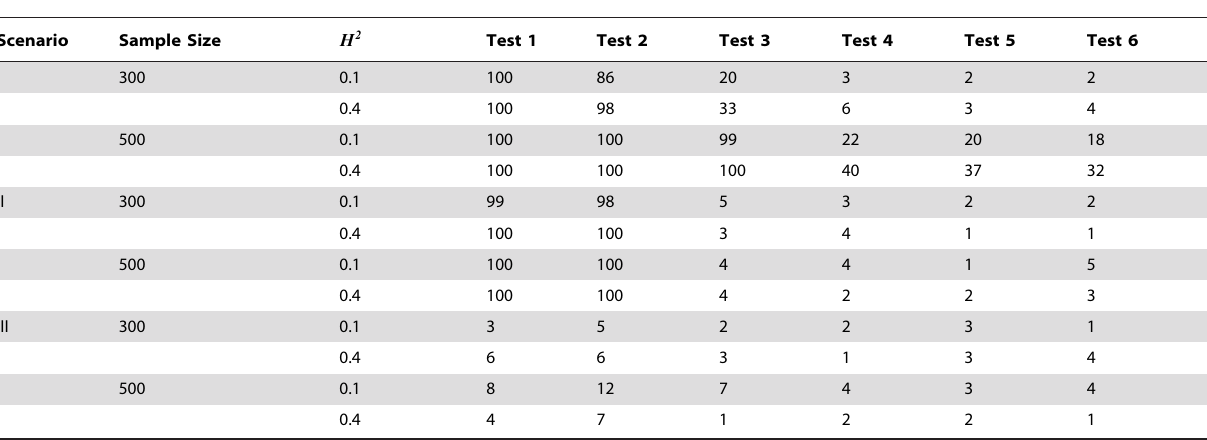
Table 5. Power and Type I error rates of the model for detecting genetic imprinting effects at different